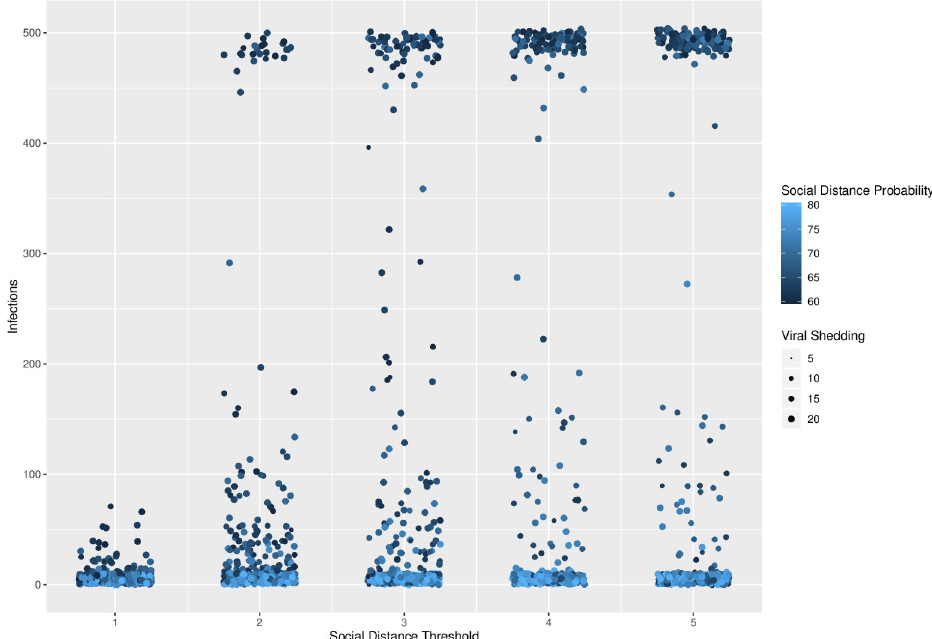
Fig 4. Social distance threshold. Social distance threshold vs. total number of infected agents for different levels of viral shedding (5% to 20%) and for social distance probabilities varying from 60% to 80% at 1% intervals. A clear phase transition exists at a social distance threshold of 1, across all levels of social distance thresholds and social distance probabilities.